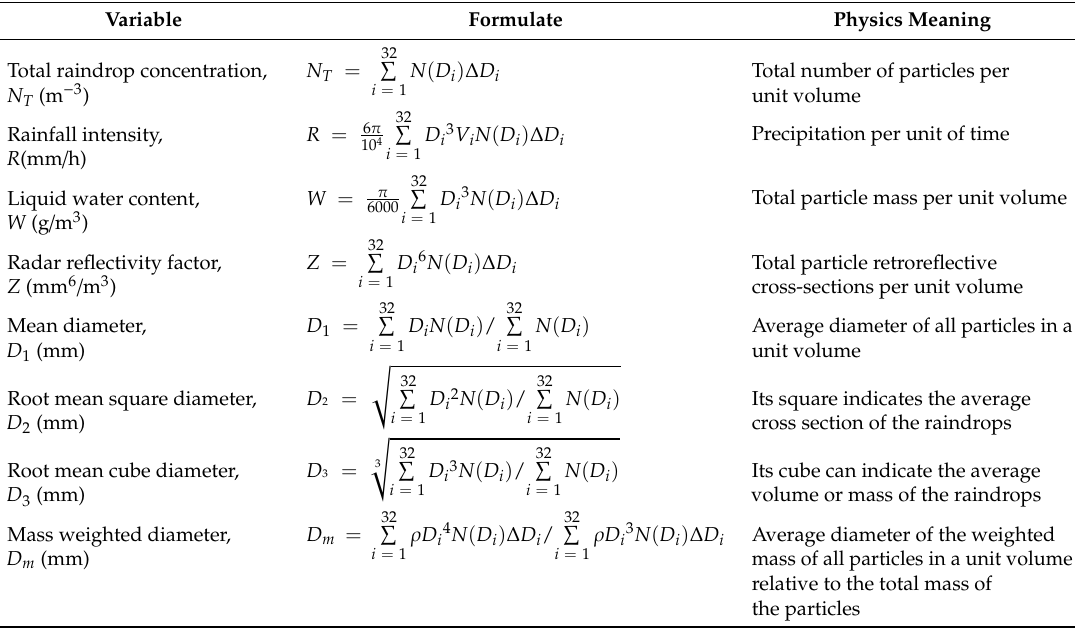
Table 1. Definition of some variables in this